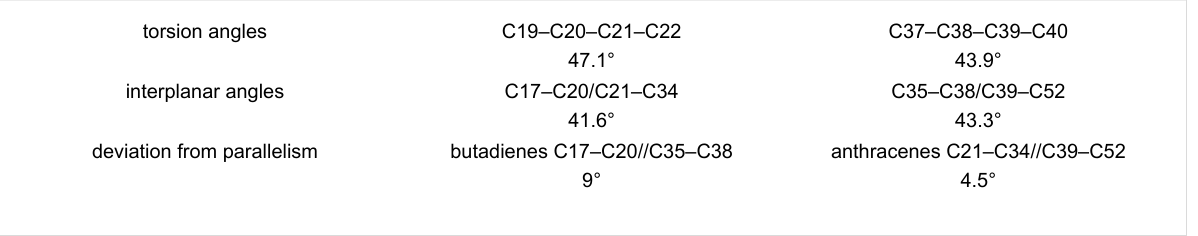
Table 1: Angles between various partial planes in molecule 2 in the crystal.